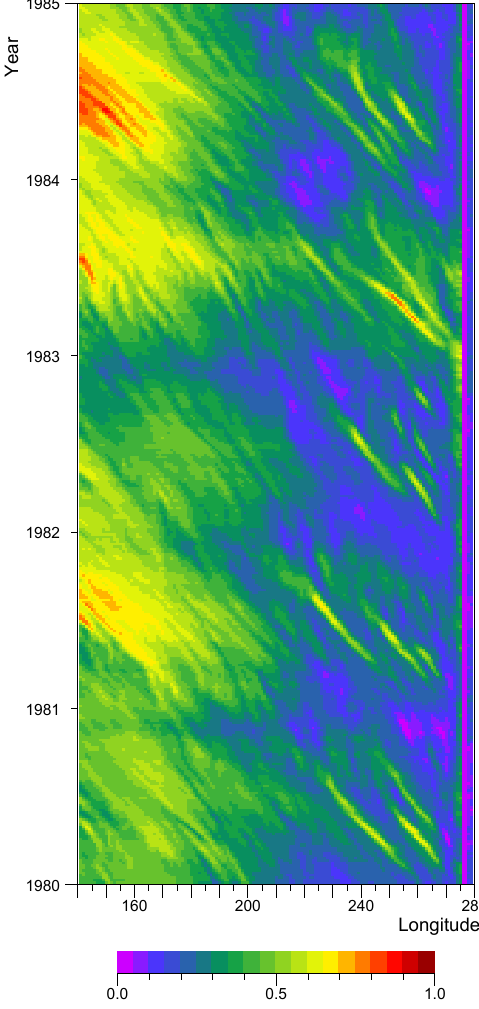
Figure 21. The model SSH (m) at 9 ◦ N as a function of time and